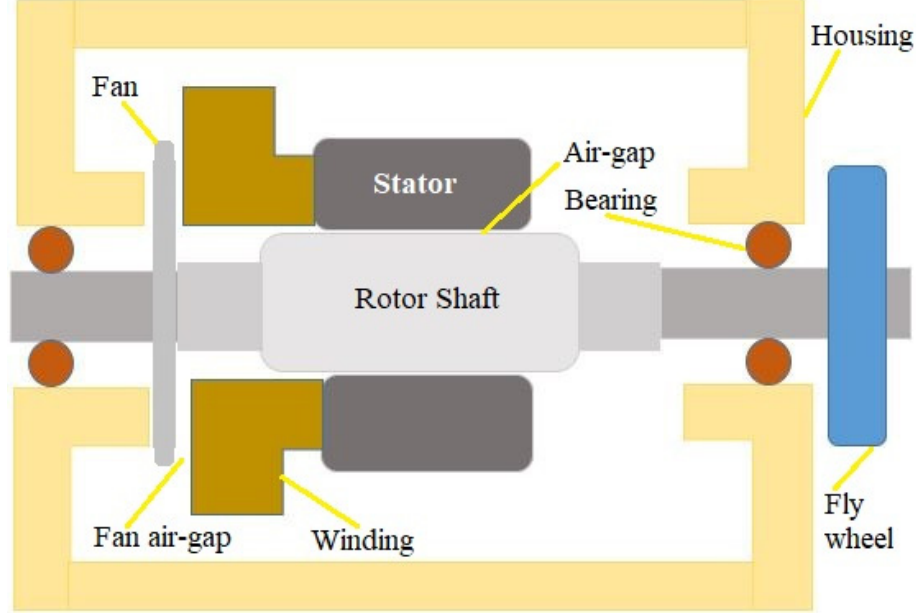
Figure 6. Results of increase in stator winding temperature [27].